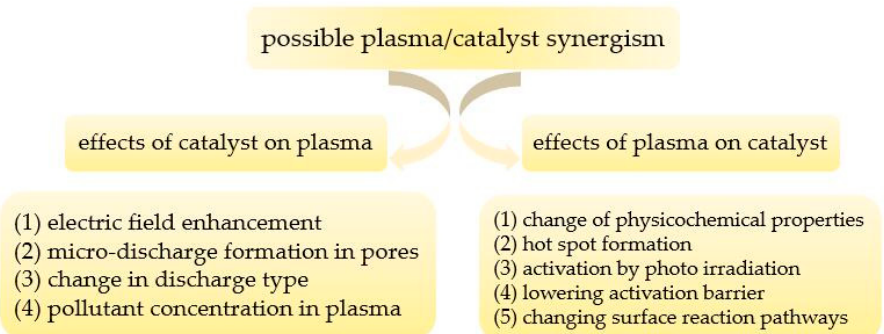
Figure 19. Overview of the various effects of catalyst on the plasma and of the plasma on the catalyst, which may give rise to a synergistic plasma-catalytic operation. Reproduced with permission from [113]. Copyright 2019 MDPI. Table 2. Comparison of CH 4 conversion and CH 3 OH selectivity in various plasma and plasma catalysis systems. System